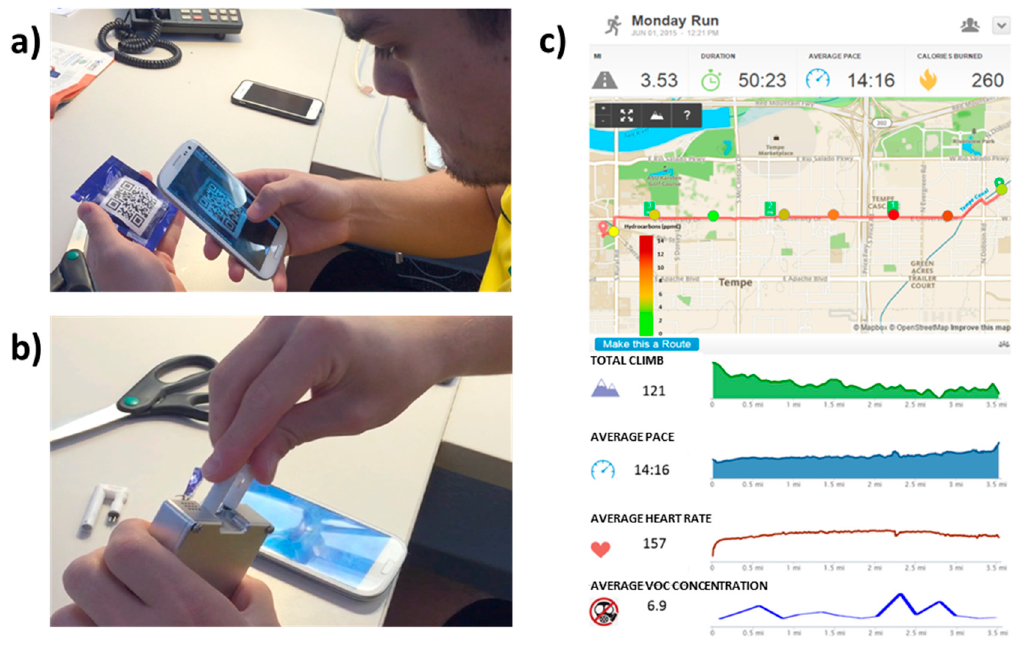
Figure 3. ( a ) Scanning sensor QR code; ( b ) Replacement of new sensor cartridge; ( c ) Real-time fitness and VOCs exposure device data during personal exercise.